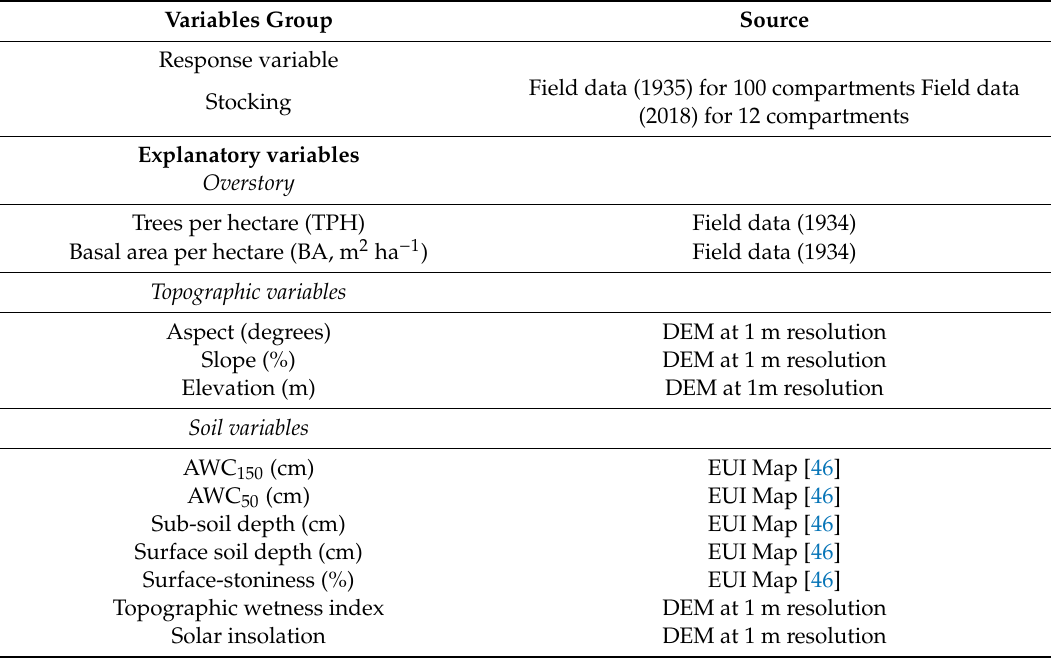
Table 2. Compartment-level response and explanatory variables.